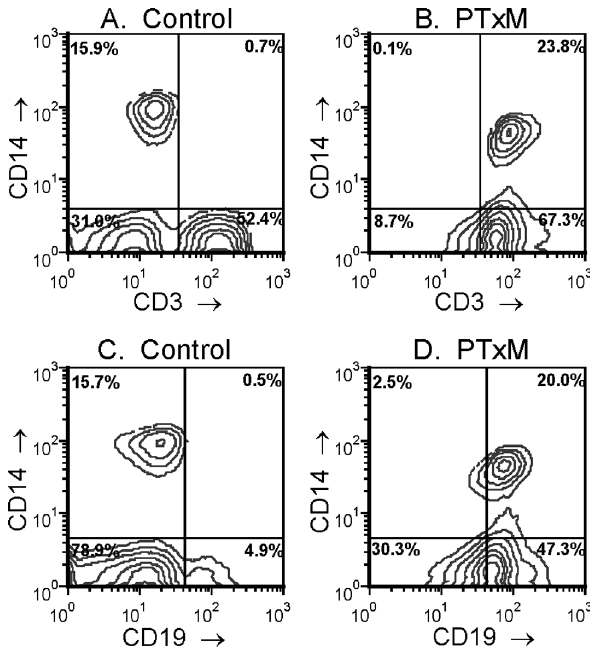
Figure 10. PTxM-mediated intercellular transfer of membrane proteins. Peripheral blood mononuclear cells (PBMC) were isolated from human donors, and stained for CD3 (a T cell marker), CD19 (a B cell marker), and CD14 (a monocyte cell marker). A. Untreated cells showing CD3 vs CD14. B. PTxM pretreated cells showing CD3 vs CD14. C. Untreated cells showing CD19 vs CD14. D. PTxM pretreated cells showing CD19 vs CD14.